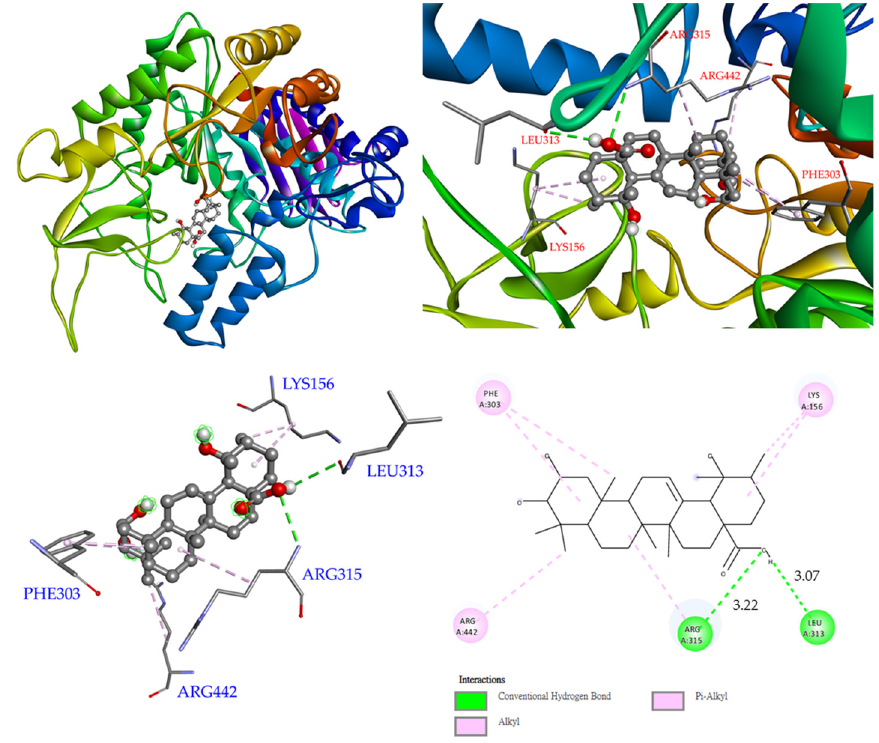
Figure 8. Interactions of euscaphic acid ( 5 ) with active sites of S. cerevisiae α -glucosidase.